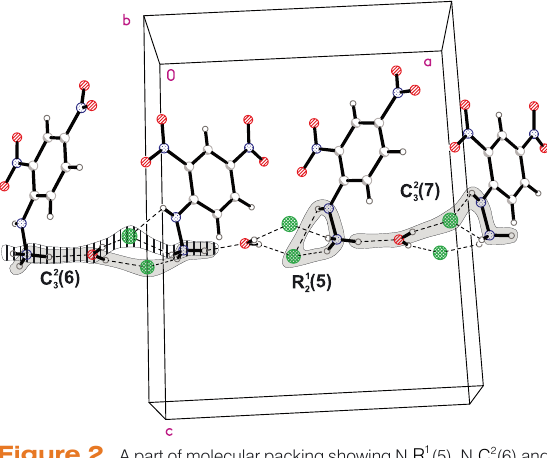
Figure 2. A part of molecular packing showing N N